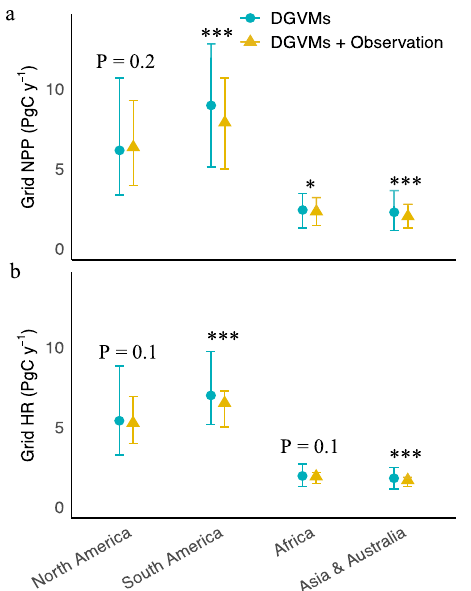
Fig. 4 Projected grid-level NPP and grid heterotrophic respiration (HR) across continents. a, b Projected (2015 – 2099) grid-level NPP a and grid- level HR b across continents quanti fi ed by six dynamic vegetation models — DGVMs (ORCHIDEE, CABLE-POP, JULES, LPJ-GUESS, LPJmL, and SEIB- DGVM). The y axes are the minimum, mean, and maximum values in six DGVMs. ‘ DGVMs ’ refers to the scenario before constraint and ‘ DGVMs + Observation ’ refers to the scenario after constraint without climate predictors. The constraint was achieved by using the observational maps ( n = 100; through a bootstrapping approach; see Methods for details) of LOSS derived from forest plots data to feed into the trained ML (random forest) model. Reported are ensemble means of constraint. The constraint effect was signi fi cant when North America were divided into temperate and boreal forests (see results of Supplementary Fig. 17). * P < 0.05; ** P < 0.01; *** P < 0.001.